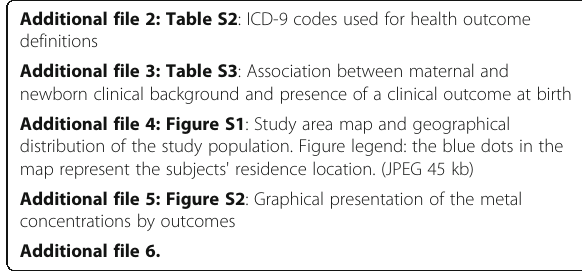
map represent the subjects' residence location. (JPEG 45 kb) Additional file 5: Figure S2 : Graphical presentation of the metal concentrations by